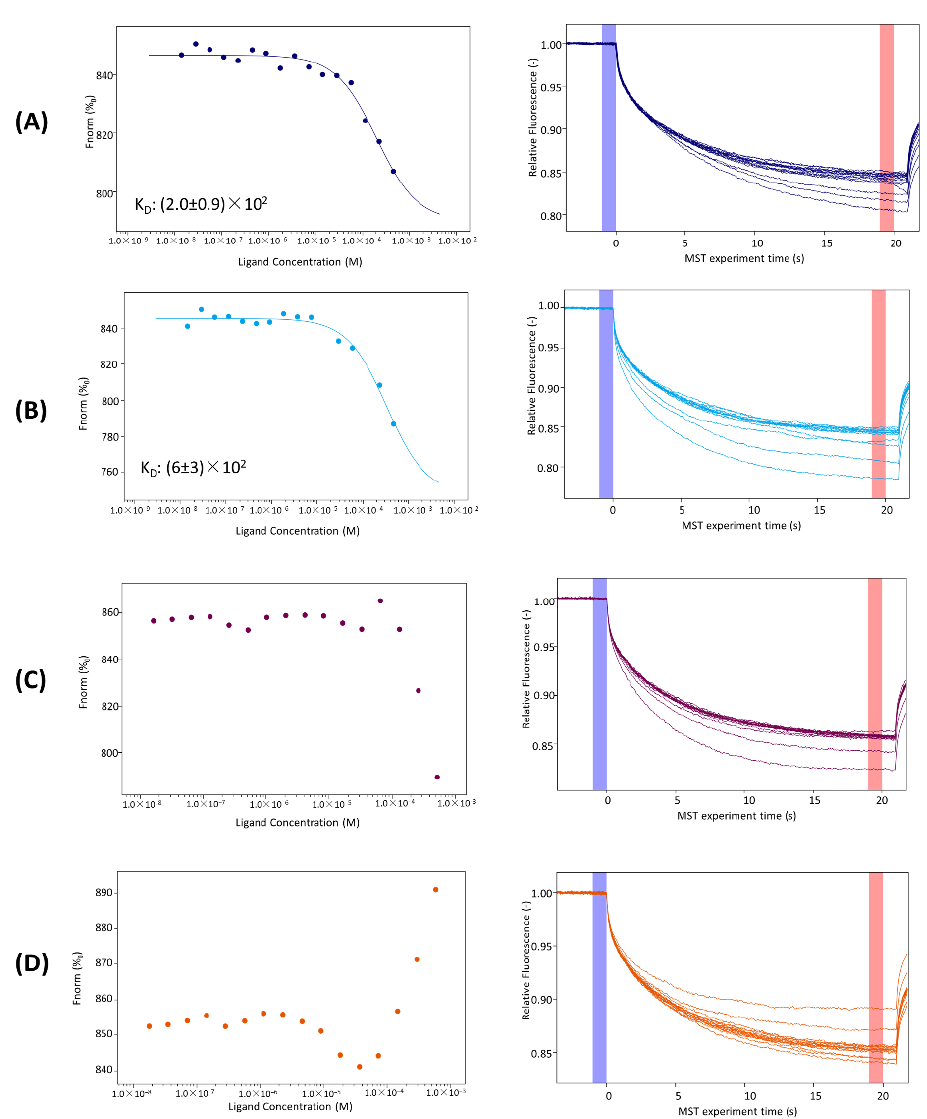
Figure 5. Left column: binding isotherms for MST signals versus peptide concentrations. Right column: thermophoretic traces of MST assays for the binding to JAK2 of ( A ) KIRCONG amide; ( B ) KIRCONG disulfide; ( C ) KIRCONG i/i+5; ( D ) KIRCONG i/i+7.